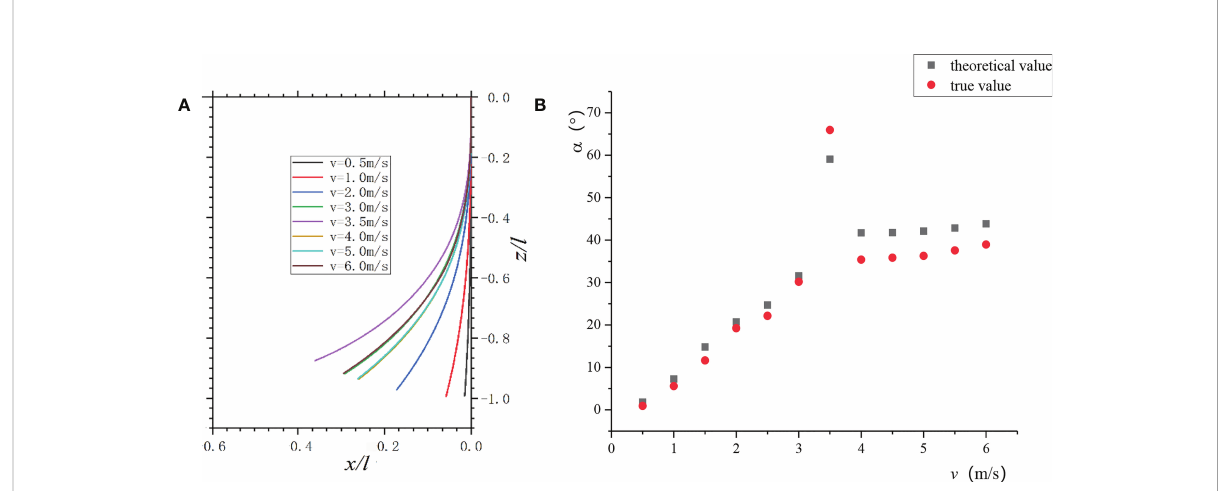
FIGURE 12 Petiole bending vs. v : (A) Change of a petiole bending with air velocities; (B) The theoretical and measured values of petiole ’ s bending under each air velocity.